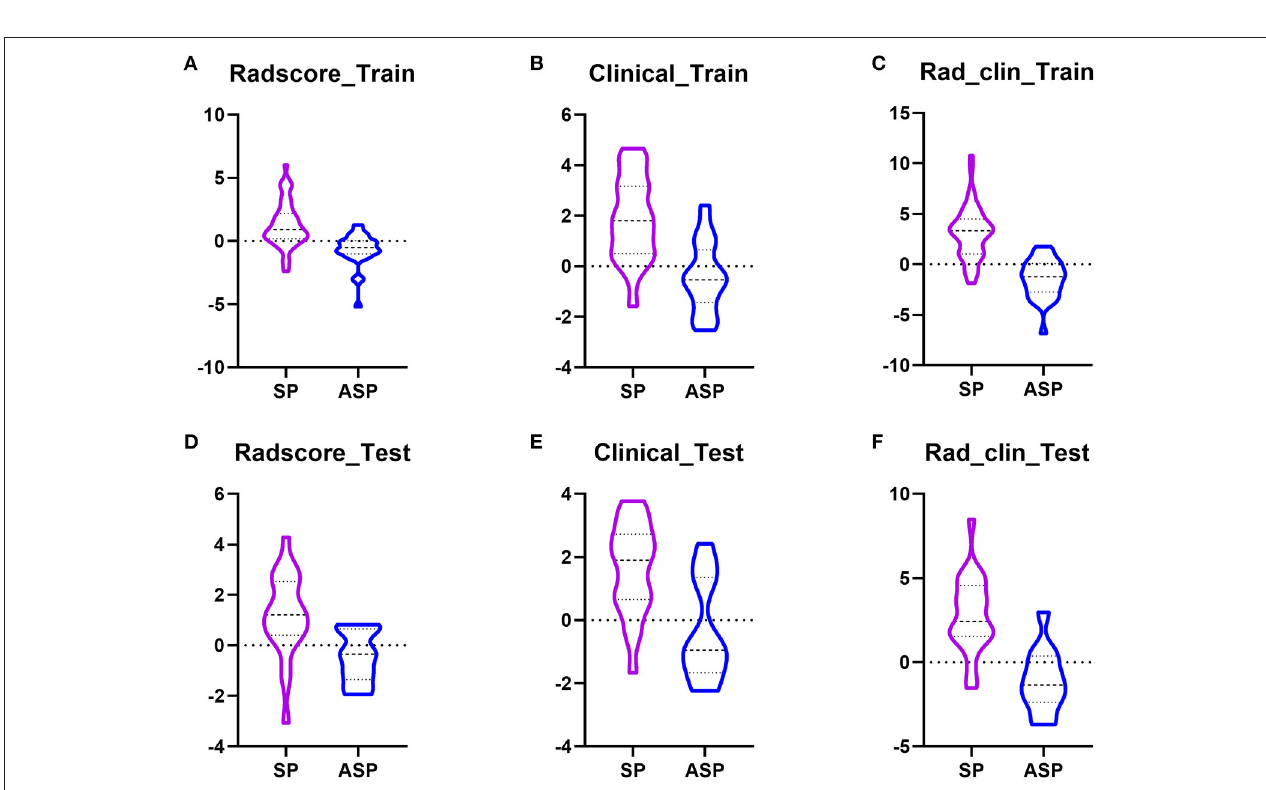
FIGURE 3 | Boxplots showed the Radscore, clinical model, and Rad_clin model value of SPs and ASPs in the training and test groups. (A,D) Radscore in the training group and the test group; (B,E) Radscore in the training group and the test group; (C,F) Radscore in the training group and the test group.